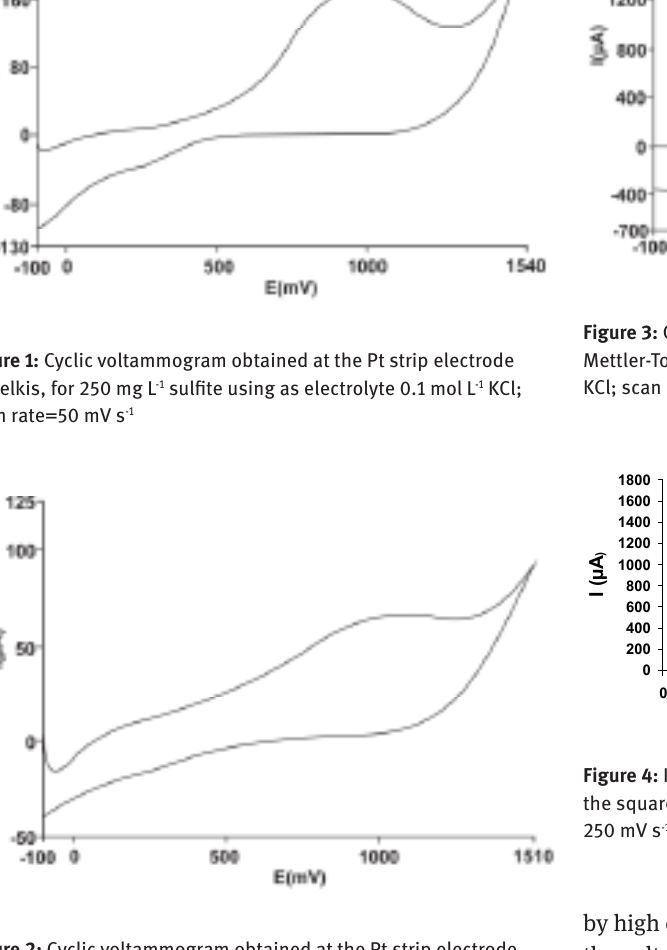
Figure 2: Cyclic voltammogram obtained at the Pt strip electrode Radelkis, for 62.5 mg L -1 sulfite using as electrolyte 0.1 mol L -1 KCl; scan rate=50 mV s -1